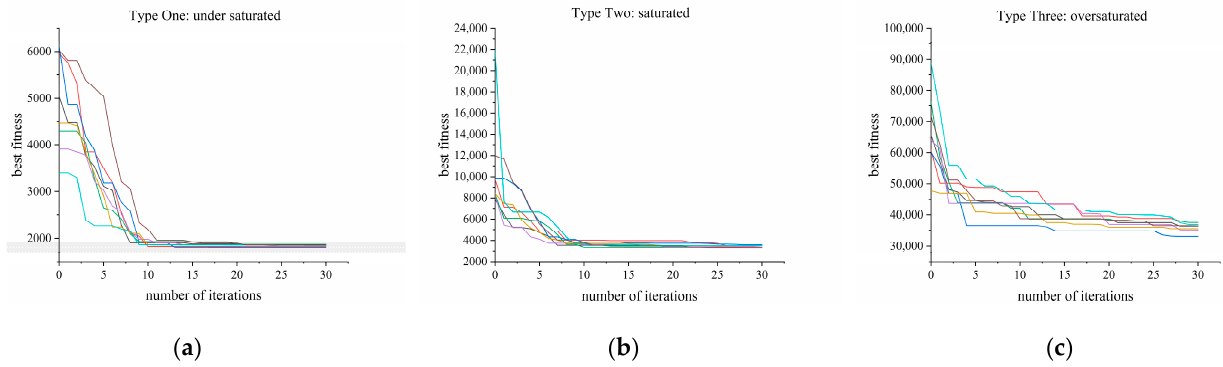
Figure 5. Trace progress of the best fitness values in 8 independent runs of LDW ‐ PSO. ( a ) Type One; ( b ) Type Two; ( c ) Type Three.